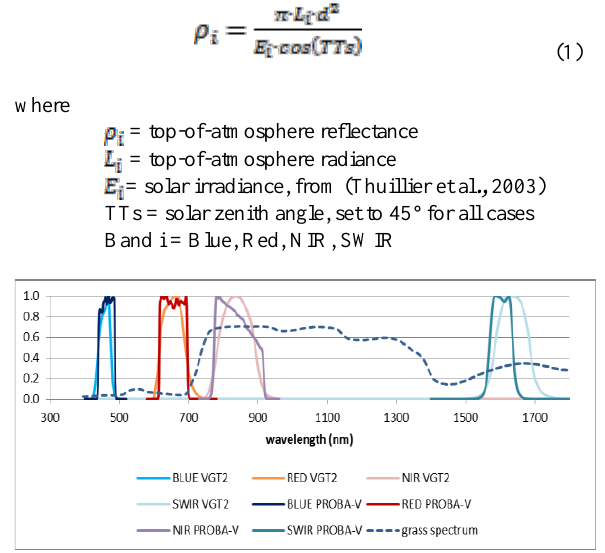
Figure 2. Spectral response functions of VGT2 and PROBA-V, superimposed with a spectrum of green grass The top-of-atmosphere reflectance values can finally be transformed to top-of-canopy reflectance by downscaling with the same atmospheric variables just for upscaling the original